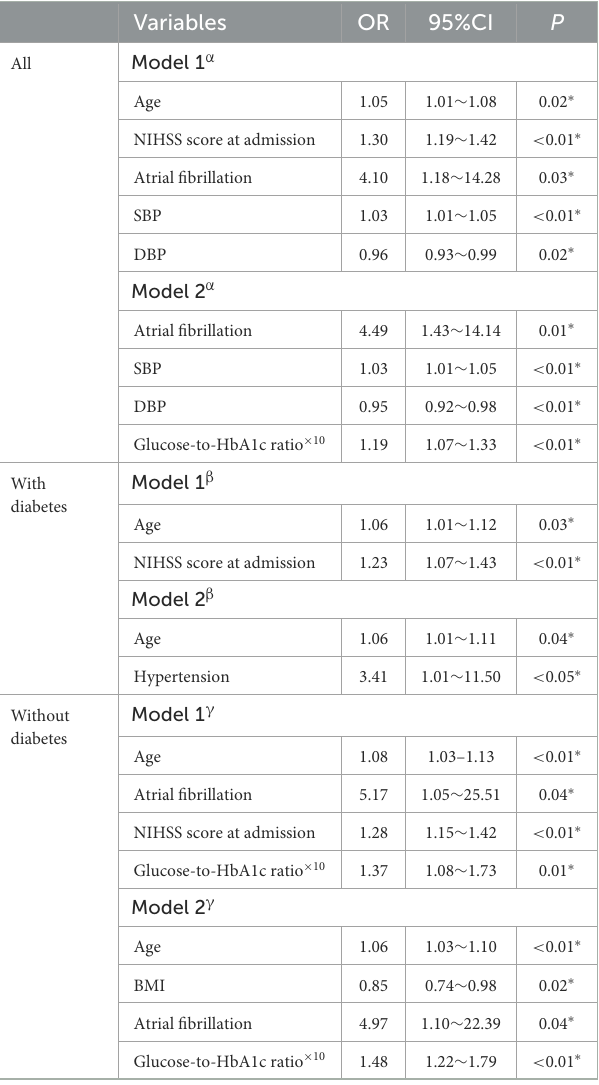
TABLE 2 Independent predictors of poor functional outcomes after 1 year in binary logistic regression